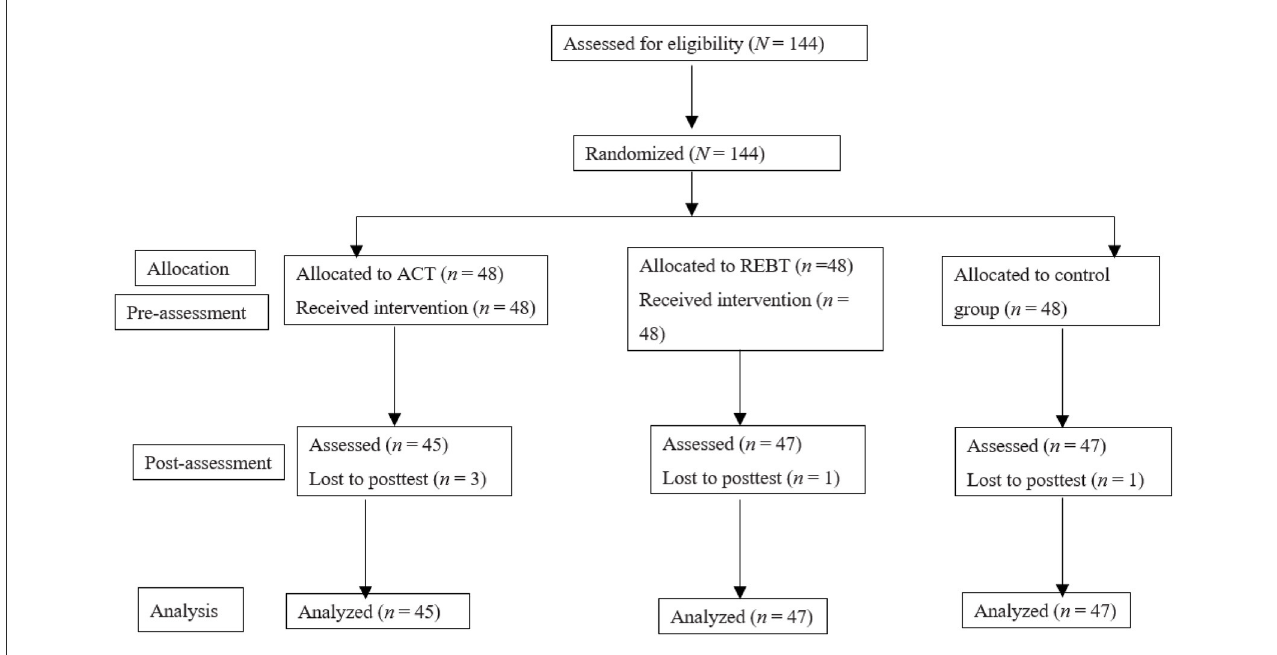
FIGURE1 Flowchart of